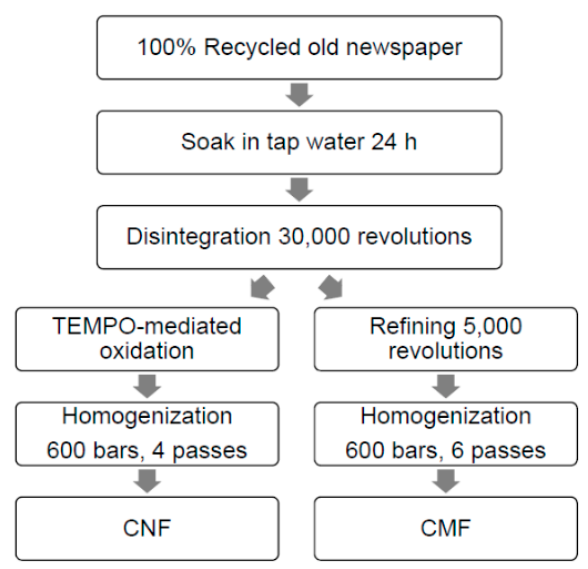
Figure 2. CMF and CNF preparation.